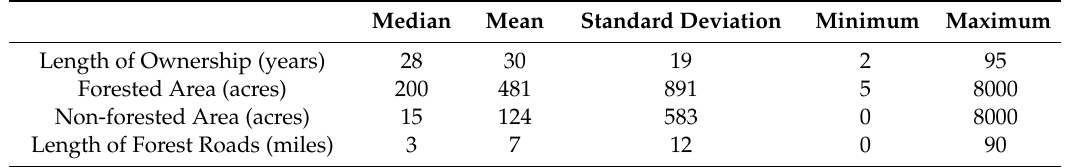
Table 1. Median, mean, standard deviation, and range of key property demographics of the property that sustained the most damage in the 2015 flood event and / or the 2016 hurricane. From a sample of Tree Farmers in 45 counties in South Carolina (June–August 2017 data